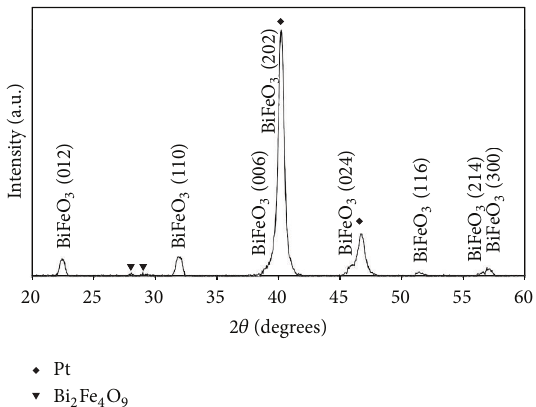
Figure 2: XRD pattern of the calcinated nanofibers showing the dominant presence of BFO. Platinum peaks are due to the Pt-coated substrate, and small traces of Bi 2 Fe 4 O 9 are found.